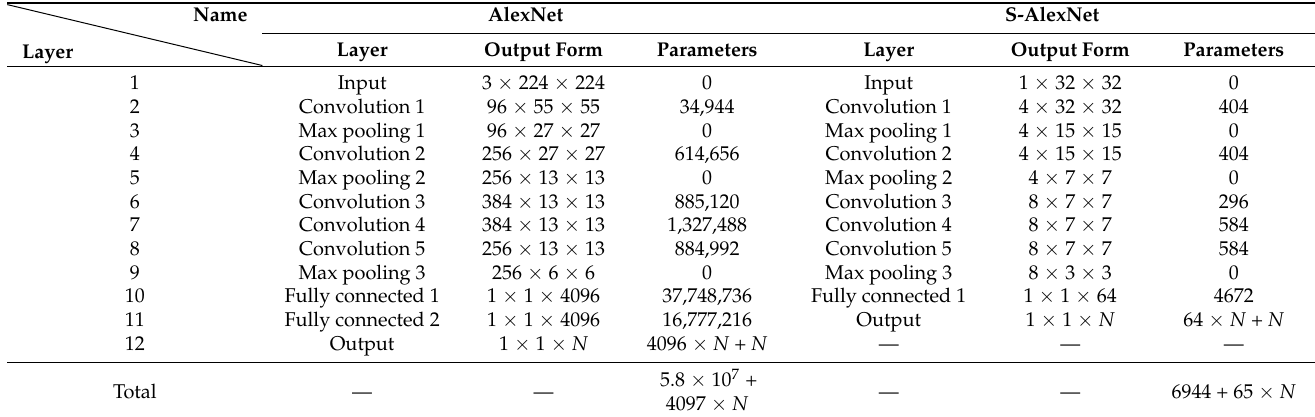
Table 1. Comparison of the structure of AlexNet and